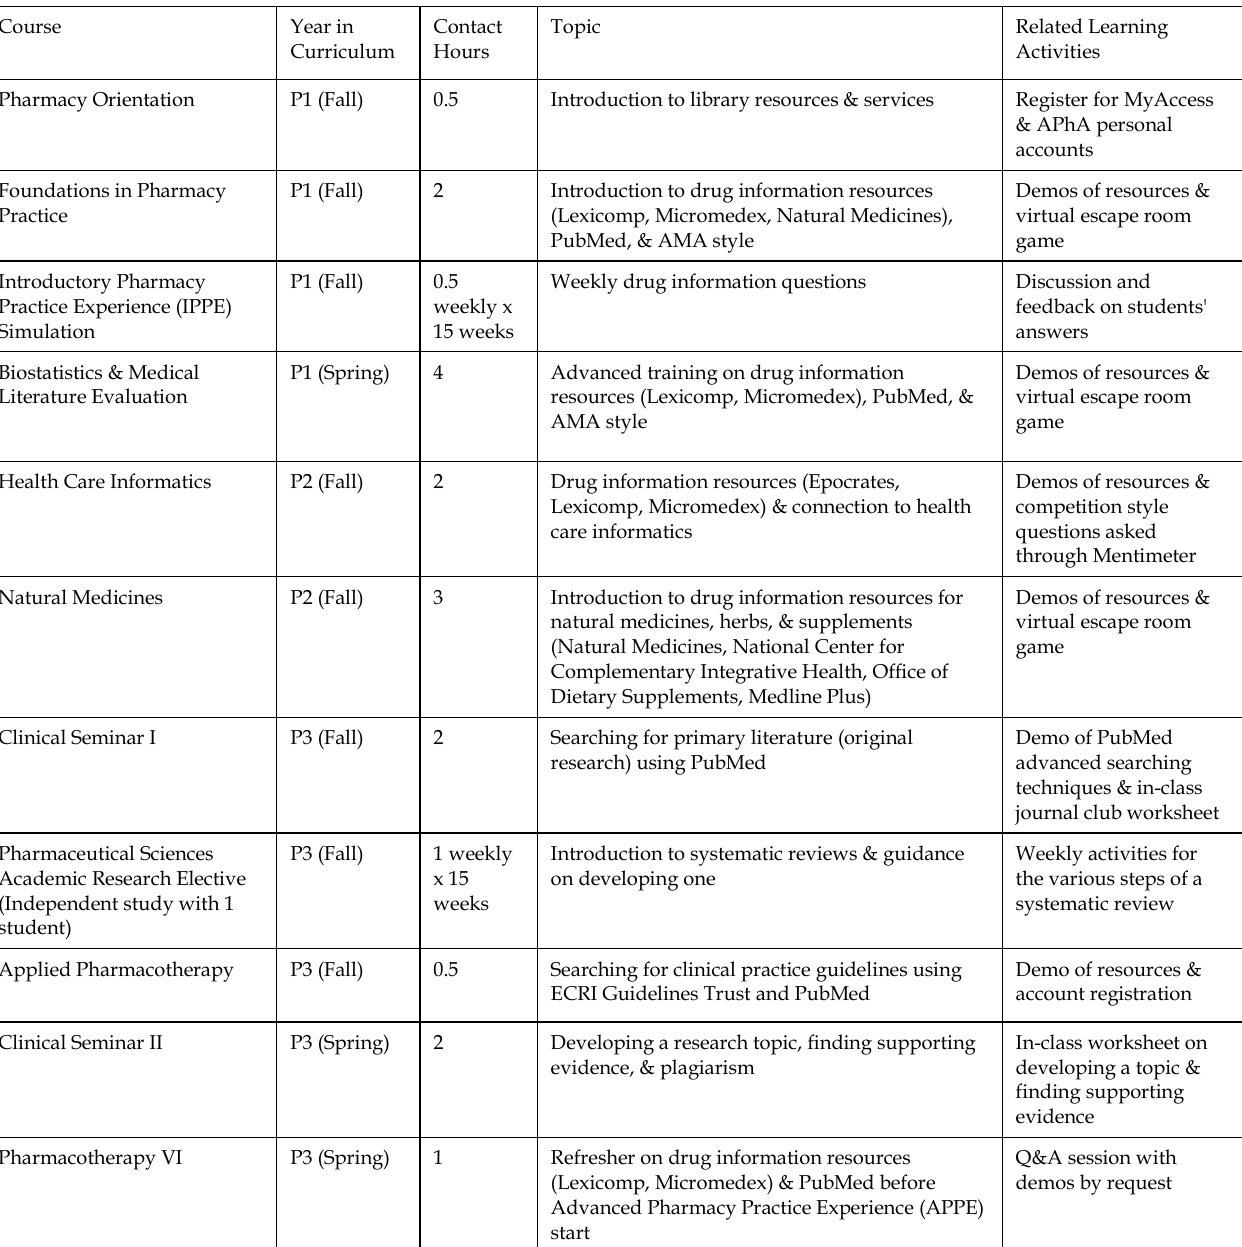
Table 1 Librarian Involvement in Pharmacy Curriculum (Average class size